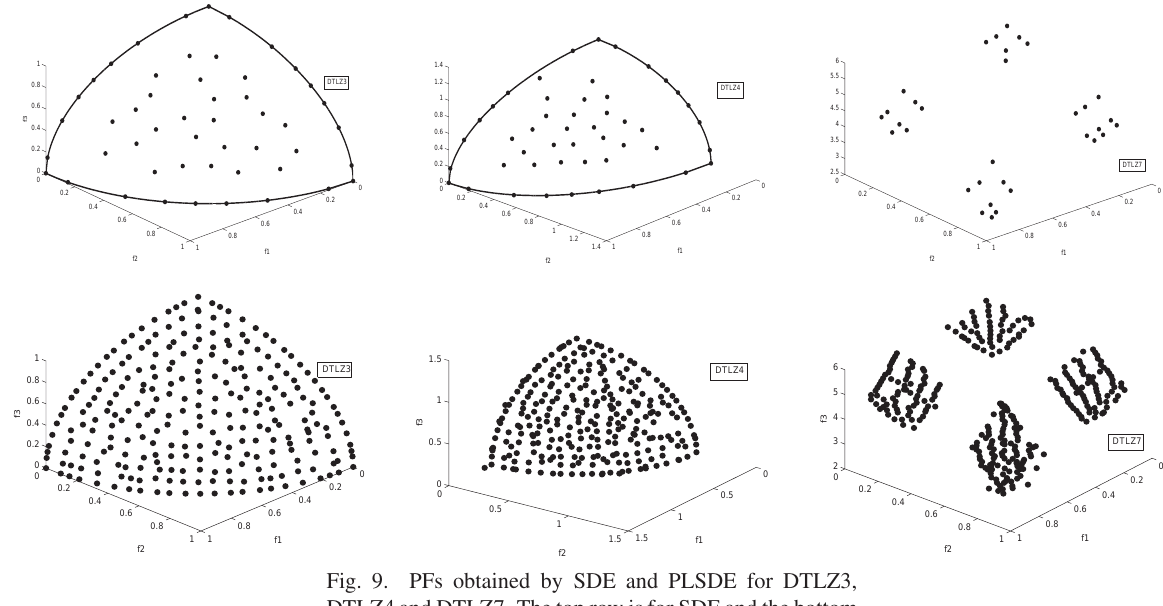
Fig. 9. PFs obtained by SDE and PLSDE for DTLZ3, DTLZ4 and DTLZ7. The top row is for SDE and the bottom one for